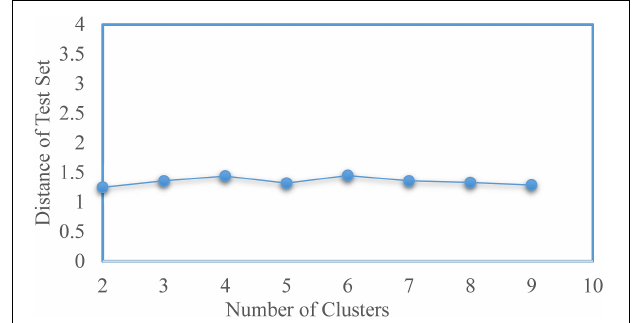
FIGURE 4 | Cross-validation to determine the number of clusters.